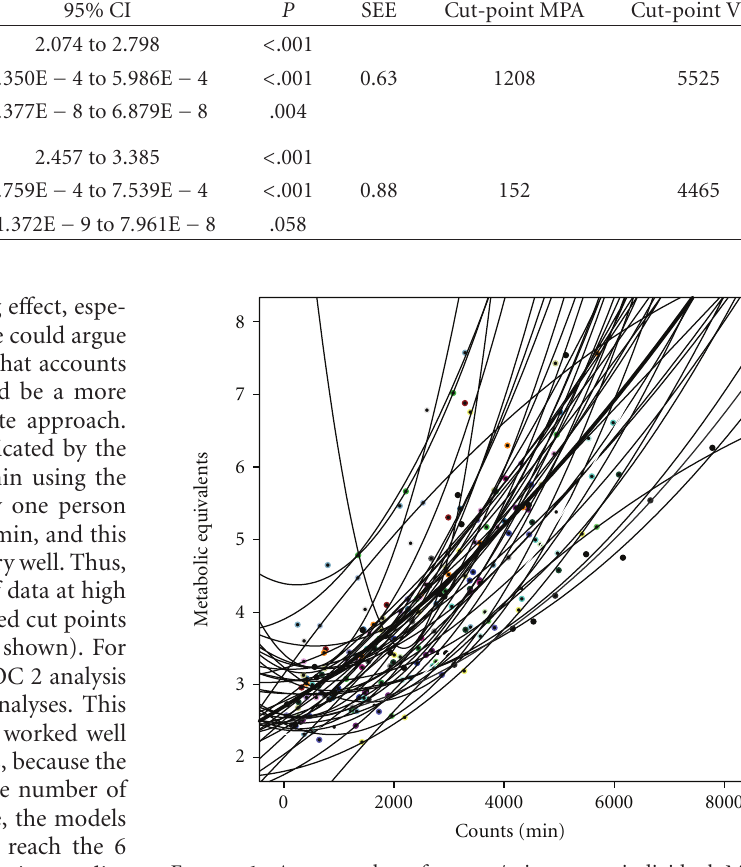
Figure 1: A scatterplot of counts/min versus individual MET values for the 42 obese-to-severely obese subjects walking on a treadmill at 2–6 km/h. The bold line indicates the regression equation derived from the linear mixed model (METs = 2.700 + 4.663E − 4 ∗ counts/min + 3.943E − 8 ∗ counts/min 2